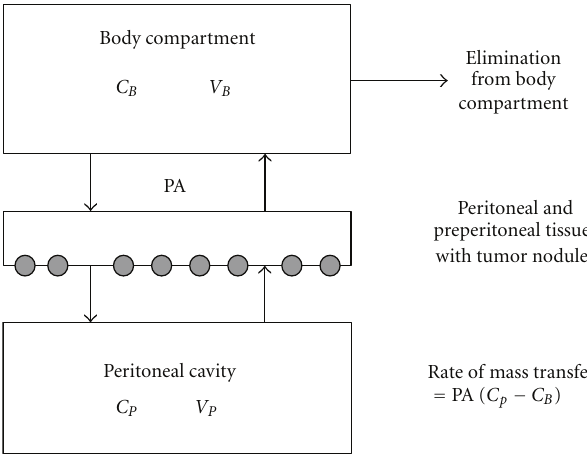
Figure 1: Traditional two-compartment model of peritoneal trans- port in which transfer of a drug from the peritoneal cavity to the blood occurs across the “peritoneal membrane.” The permeability- area product (PA) governs this transfer and can be calculated by measuring the rate of drug disappearance from the cavity and dividing by the overall concentration di ff erence between the peritoneal cavity and the blood (or plasma). C B : the free drug concentration in the blood (or plasma); V B : volume of distribution of the drug in the body; C P : the free drug concentration in the peritoneal fluid; V P : volume of the peritoneal cavity. Modified from R. L. Dedrick, M. F. Flessner: pharmacokinetic problems in peritoneal drug administration: Tissue penetration and surface exposure [31]. Table 1: Molecular weight and area under the curve ratios of intraperitoneal exposure to systemic exposure of chemotherapeutic agents used to treat peritoneal